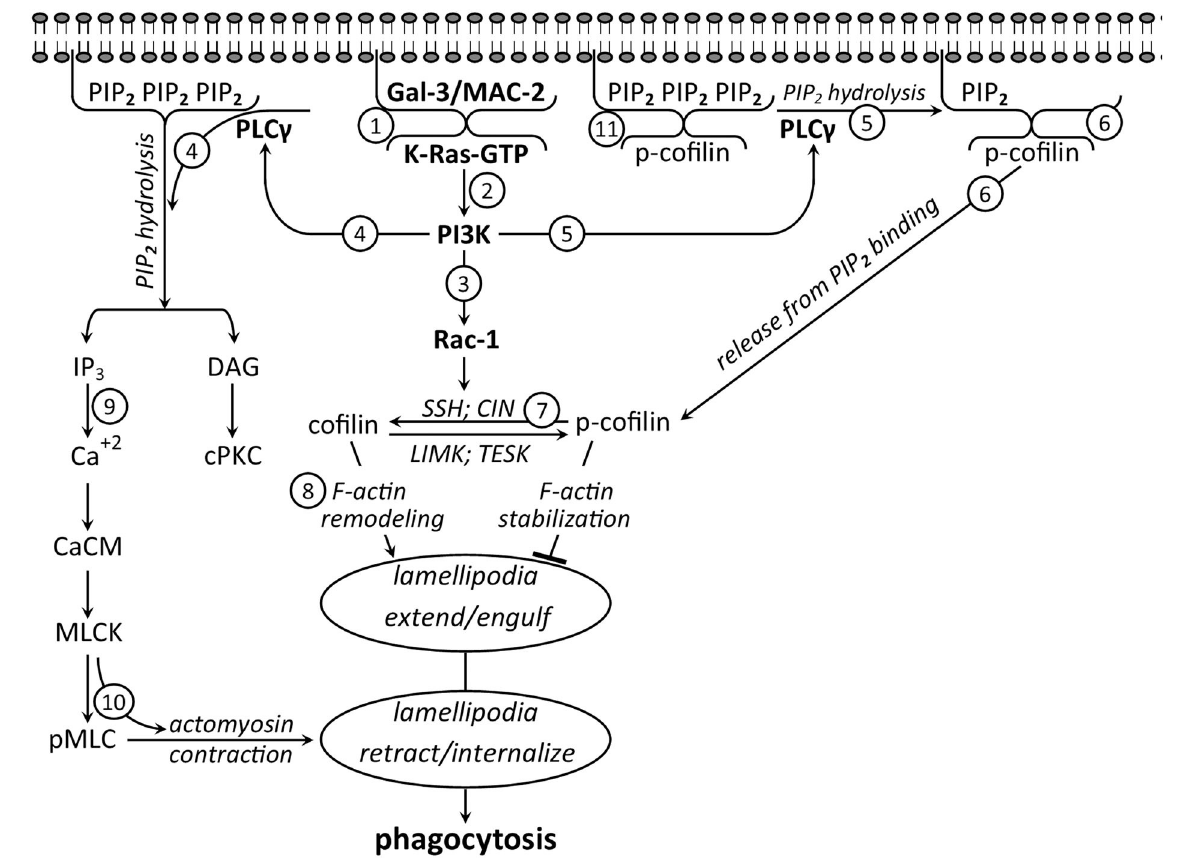
FIGURE2 Intracellular Gal-3/MAC-2 takes center stage in promoting phagocytosis—a suggested signaling network based on the literature discussed in the text (not all signaling molecules that are involved in phagocytosis are shown). Before phagocytosis , cytoplasmic (1) Gal-3/MAC-2 and (11) PIP2 are attached to the inner surface of the plasma membrane, and further, (11) PIP2 binds inactive cofilin (p-cofilin), blocking its accessibility to activation by phosphatases. Phagocytosis starts as myelin debris (not shown) binds and activates CR3/MAC-1 (not shown) to generate the signaling network. Initially, (2) activated K-Ras-GTP forms a complex with Gal-3-MAC-2. In complex, (2) Gal-3/MAC-2 augments and prolongs K-Ras-GTP-dependent activation of PI3K, which, in turn, activates (3) Rac1 and (4 and 5) PLC γ . Consequently, (3) Rac1 activates phosphatases slingshot (SSH) and chronophin (CIN), (4) PLC γ hydrolyzes PIP2 into DAG and IP3, and (5) PLC γ -dependent hydrolysis of PIP2 (6) reduces PIP2 concentration at the plasma membrane, leading to the release of inactive p-cofilin from PIP2 inhibitory binding. Subsequently, (7) inactive p-cofilin becomes accessible to activation by phosphatases SSH and CIN that (3) Rac1 has activated. Then, (8) active cofilin advances F-actin remolding, leading to filopodia/lamellipodia extension and engulfment of myelin debris. Thereafter, (4) PIP2 hydrolysis product IP3 (9)